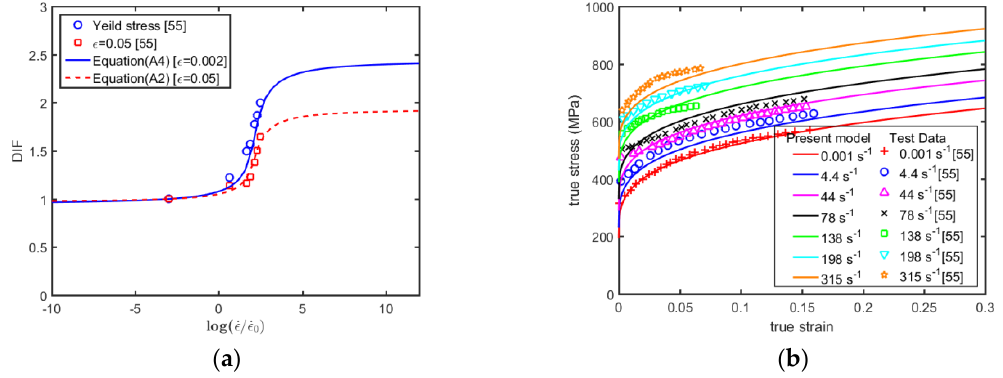
Figure A4. Comparison of the present model with the test data for Q235B mild steel. ( a ) DIF at different plastic strains versus strain rate at room temperature; and ( b ) true tress-true strain curves in compression.